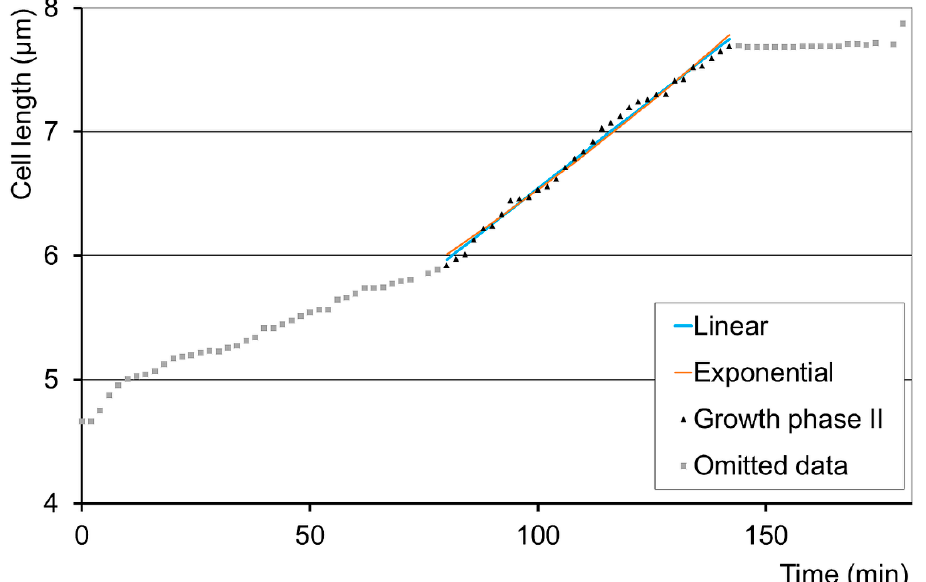
Figure 3. Illustrative length growth profile of the same individual wee1-50 mutant fission yeast cell, which is given in Figure 1. Growth phase II is emphasized here, as the rest of the data is omitted from this analysis. The two fitted models (linear and exponential) are shown. Table 2. Results of the two-sample t -tests for analysing the growing phases in those wild-type cells, which grew